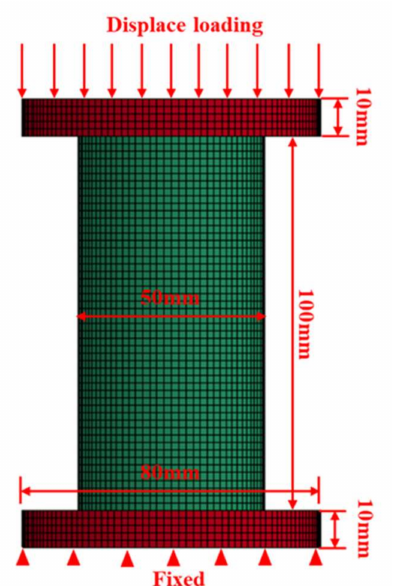
Figure 9. Relationship between P and µ of Indian limestone.